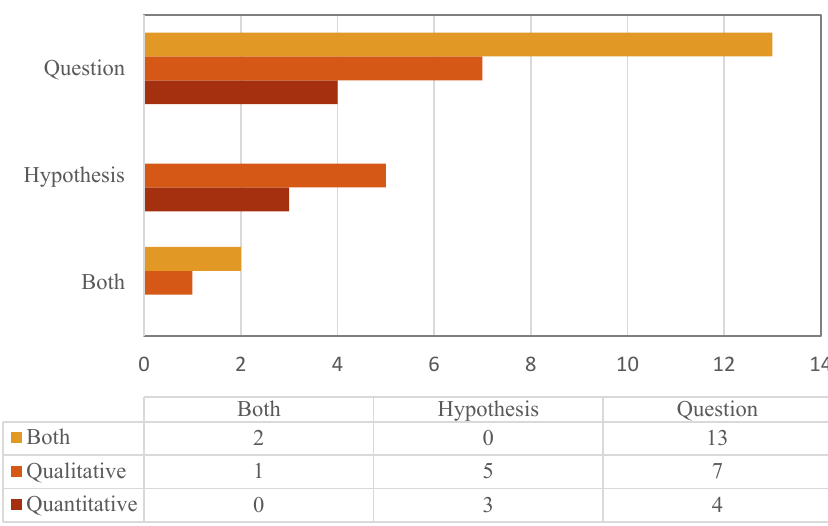
Fig. 6: Comparison of research types and data collection methods in direct studies